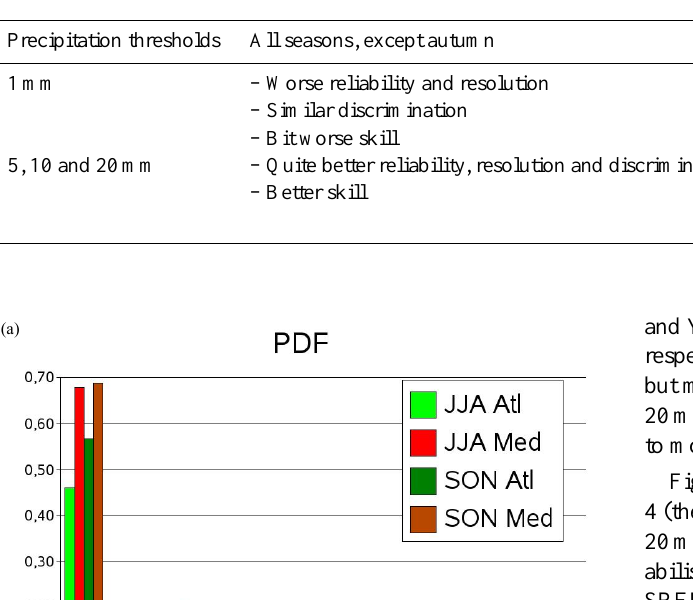
Table 2. AEMET-SREPS probabilistic precipitation forecasts performance. Summary over Mediterranean area with respect to Atlantic area in terms of standard scores for EPSs evaluation.